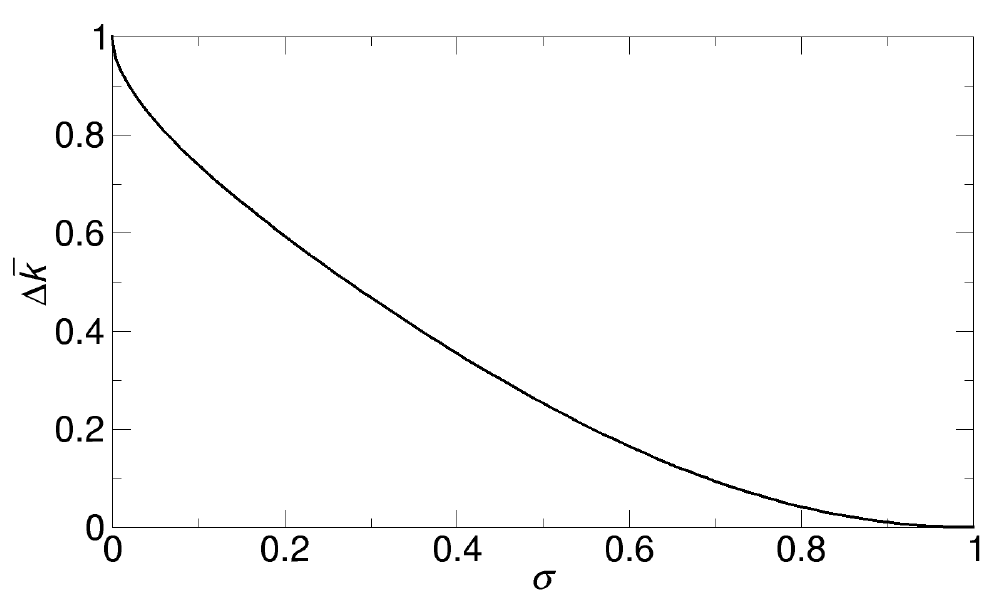
Figure 11. Variations ∆𝑘̅ calculated from Equation (12) for the Lu reaction systems as a function of the total reactive area fraction 𝜎 .